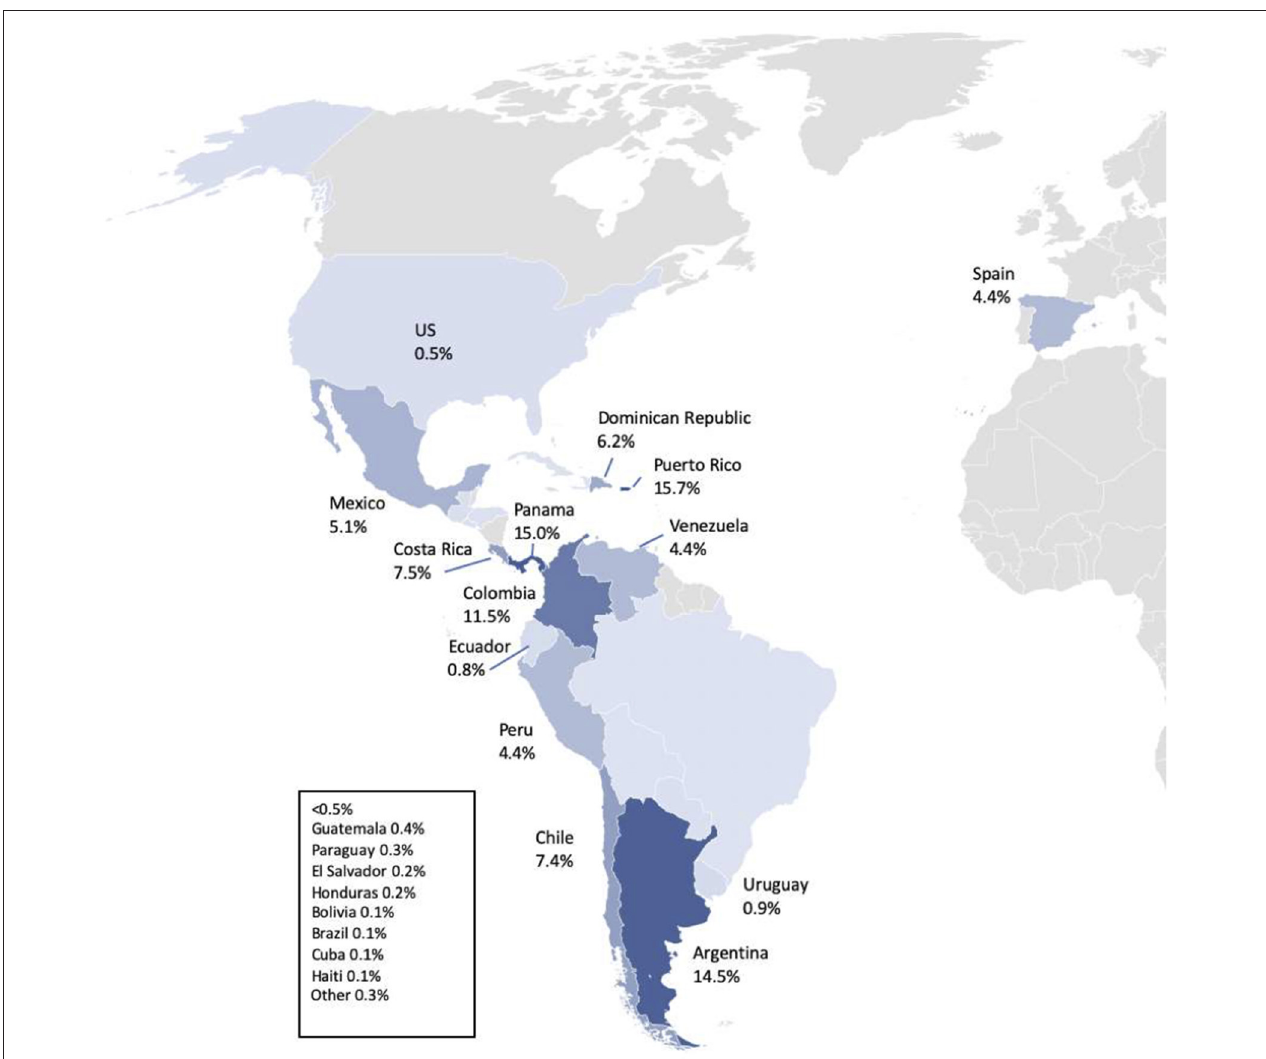
FIGURE 2 | Countries of birth of study participants. Responses were received from 23 countries in South and Central America, the Caribbean, Spain, and the